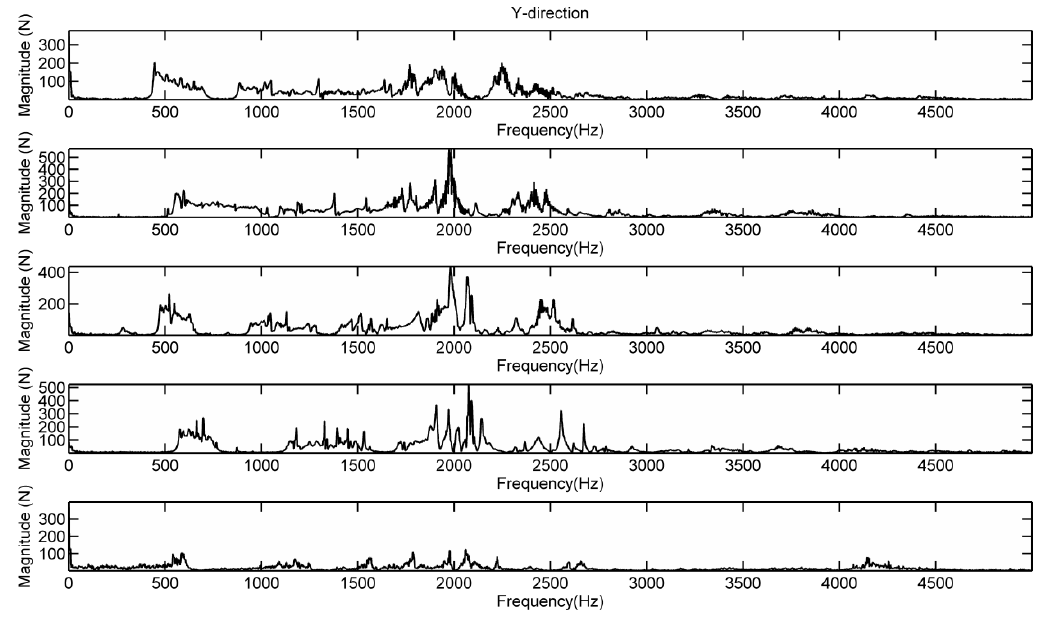
Figure 14. Y-directional force responses of the bridge. From upper to lower: lower 3, 2, and 1 tones, in tune, and higher 1